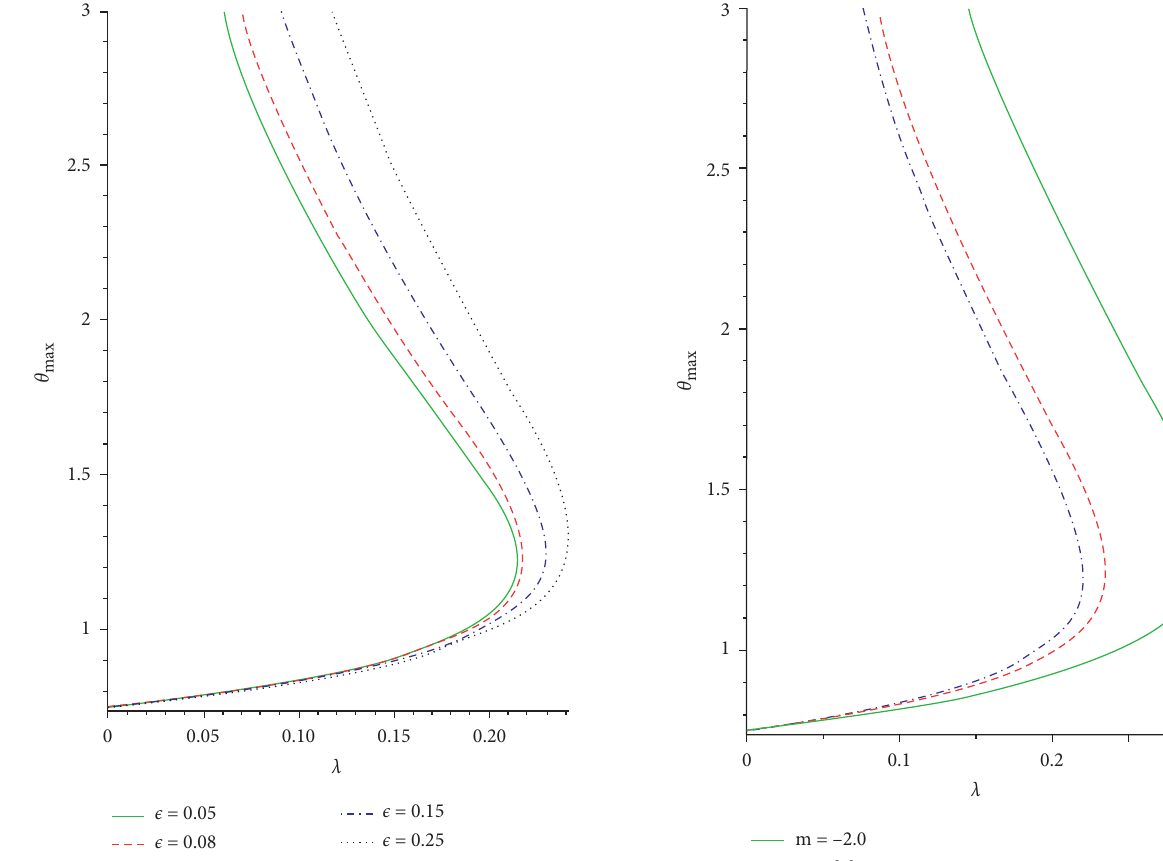
Figure 8: Criticality bifurcation for rising ϵ .